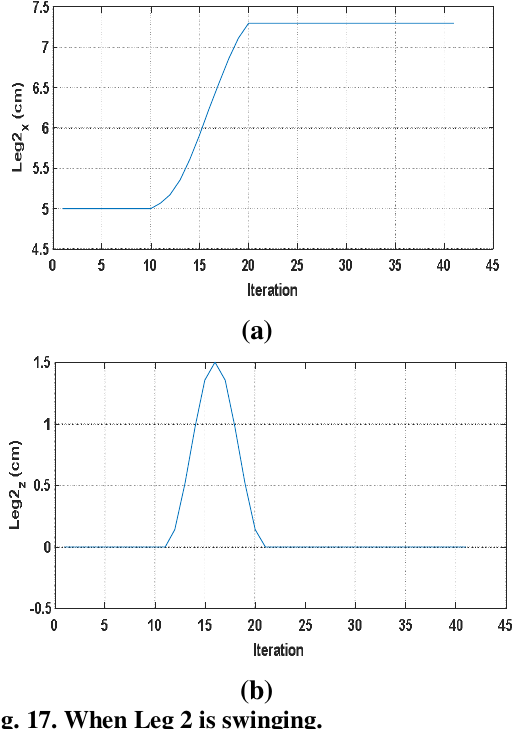
Fig. 17. When Leg 2 is swinging. (a) Leg 2 moved one step along X-axis. (b) Leg 2 moved one step along Z-axis.